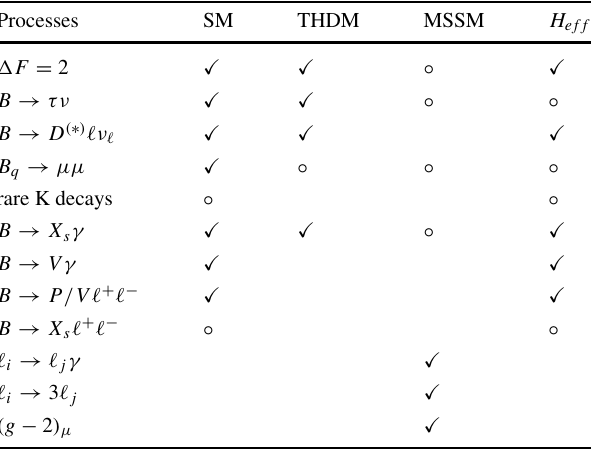
Table 6 Some processes that have been implemented ( (cid:2) ) or are under development ( ◦ ) in HEPfit for flavour